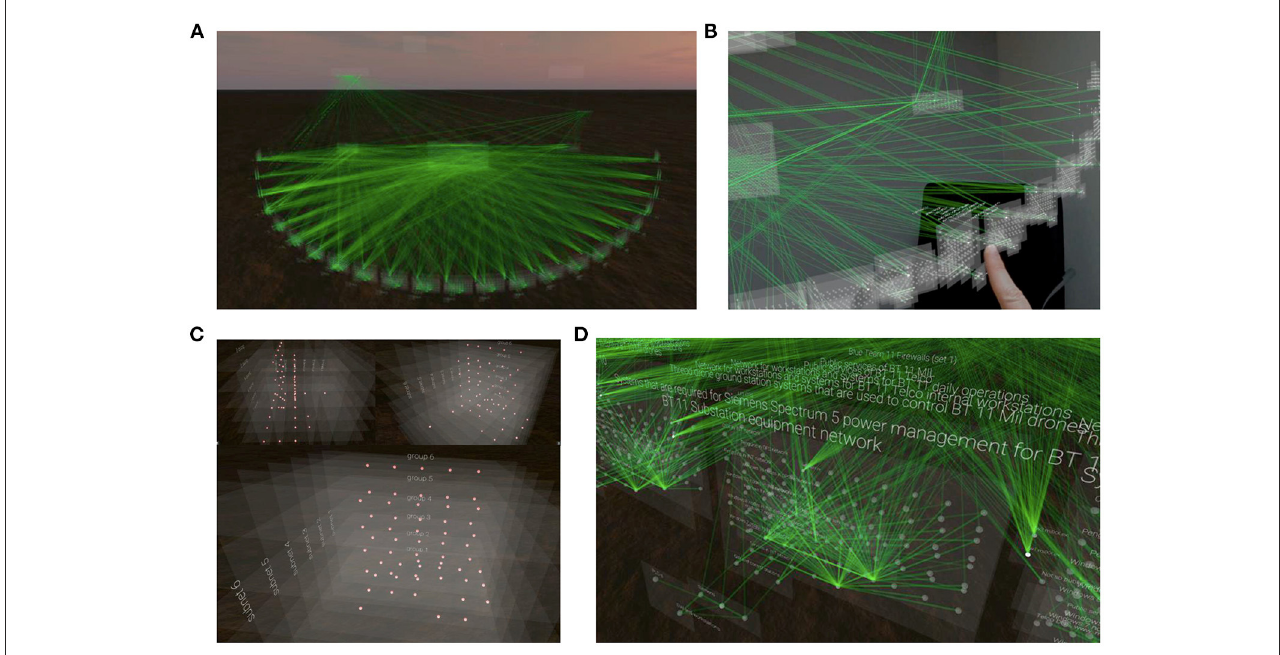
FIGURE2 Visualization of network topography using the Virtual Data Explorer app. (A) Full overview of the metashape of the actual network that was used during the NATO CCDCOE 2018 Locked Shields event as visualized in VR using the VDE app. (B) An individual interacting with the network topography in MR. (C) A close-up of nodes in the network from different angles and without the edges representing the connections between them. (D) A close-up of Blue Team nodes in the network with descriptive information and the edges that connect them. Images taken from Kullman et al. (2019a).